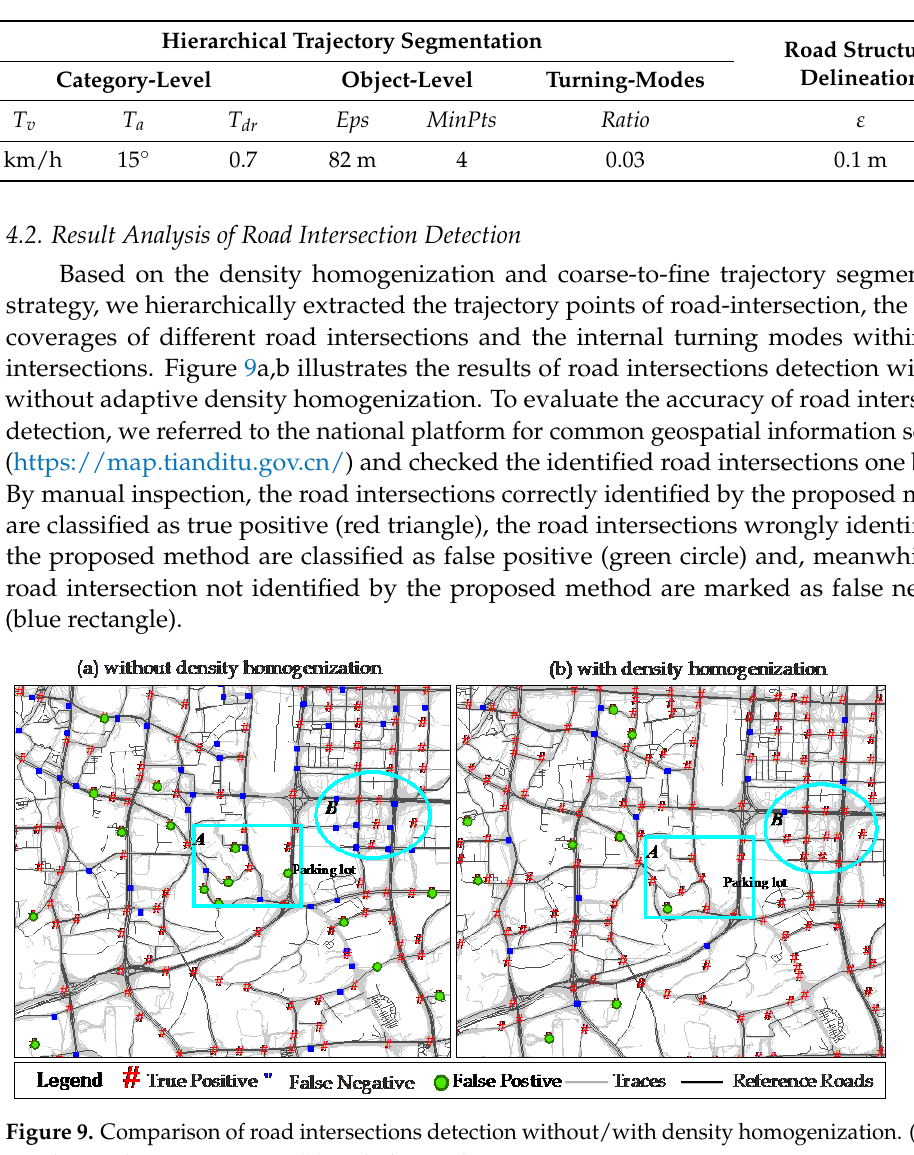
Table 2. Experimental parameters setting.